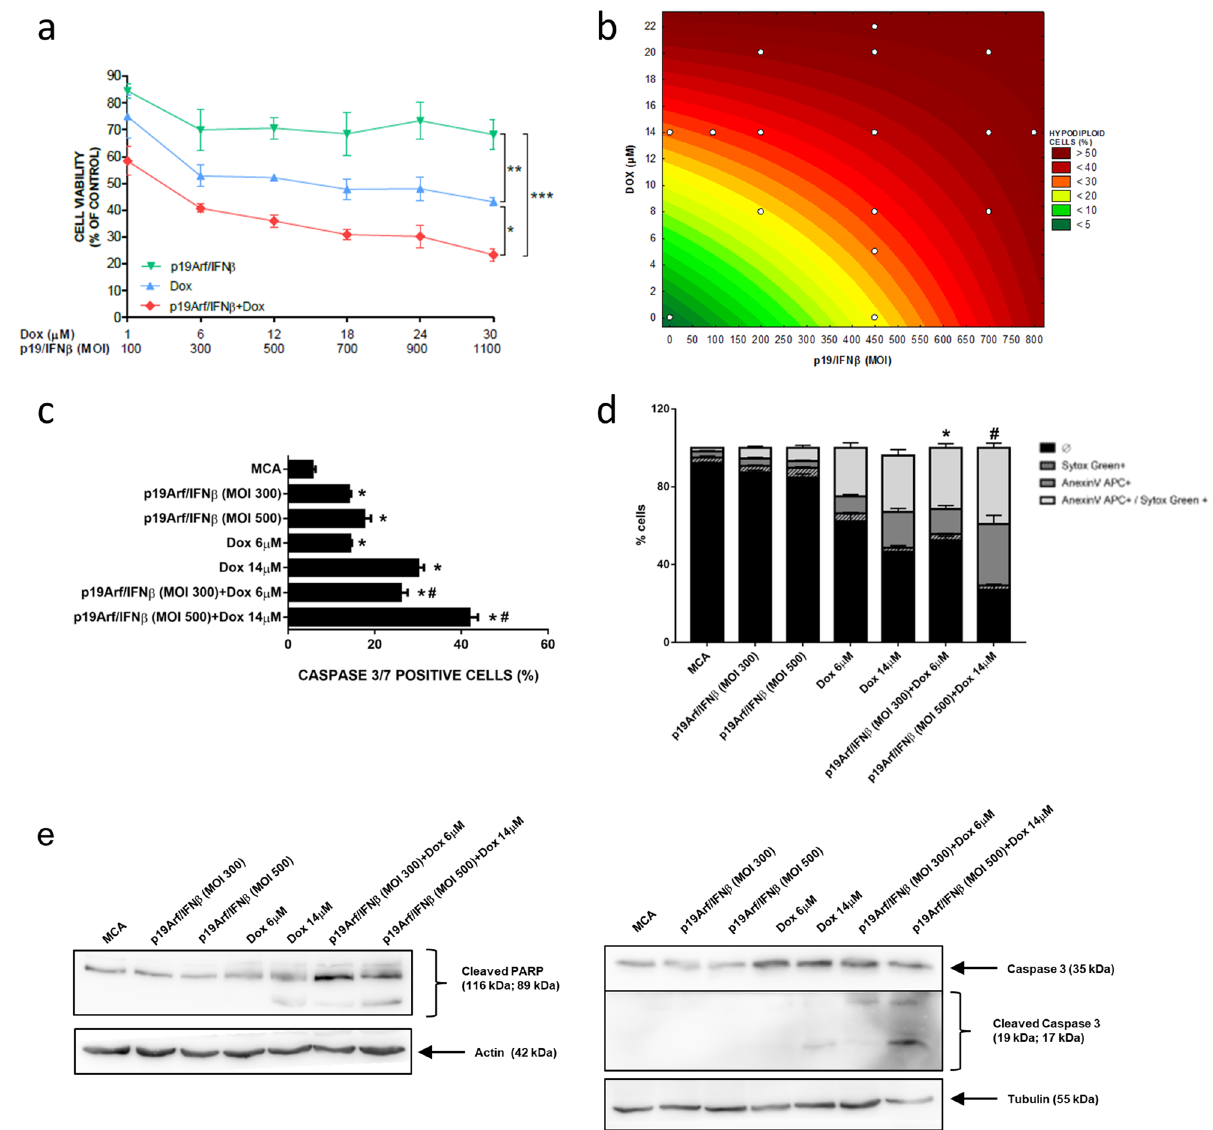
Figure 2. In vitro association of p19Arf/IFNβ and doxorubicin augments cell death levels. ( a ) MTT analysis of MCA cells treated for 12 h individually or in combination with doxorubicin and AdRGD-PG-p19 and AdRGD- PG-IFNβ vectors. n = 4 [One-way Anova and Tukey’s multiple comparison post-test]. ( b ) Response surface plot illustrating the influence of different p19Arf/IFNβ MOIs and doxorubicin concentrations on the percentage of hypodiploid MCA cells after 20 h of treatment, for which interactions were considered significant by the ANOVA and Pareto chart analysis. ( c ) Flow cytometry analysis of caspase 3 activity in MCA cells after 16 h of p19Arf/IFNβ and of doxorubicin treatment. Each assay performed on 3 independent occasions with technical duplicates. One-way Anova with Sidak’s post-test. *p < 0.0001 vs CTR; # p < 0.0001 p19Arf/IFNβ + Dox vs p19Arf/ IFNβ or Dox ( d ) Fresh MCA cells, treated as indicated, were stained to reveal apoptotic cells (AnnexinV APC +) or advanced cell death (Sytox Green +) before observation by flow cytometry. Each assay performed on 3 independent occasions with technical duplicates. Two-way Anova with Tukey’s post-test. ( e ) Representative image of two independent Western blotting experiments of cleaved PARP or caspase 3 with or without cleavage upon treatment of MCA cells (N =